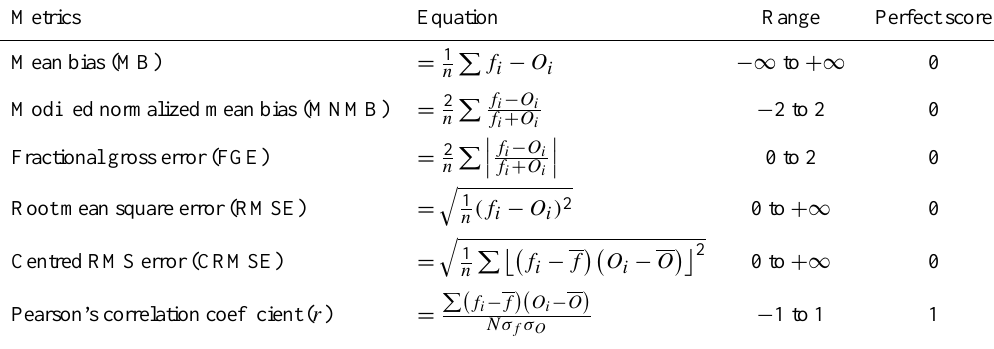
Table A1. Metrics used to quantify the level of agreement between MACC-II simulations and the observations, where n is the number of data used in the validation, f i is the estimated value by MACC-II or the observed value by satellite sensors, and O i is the observed reference (“true”)